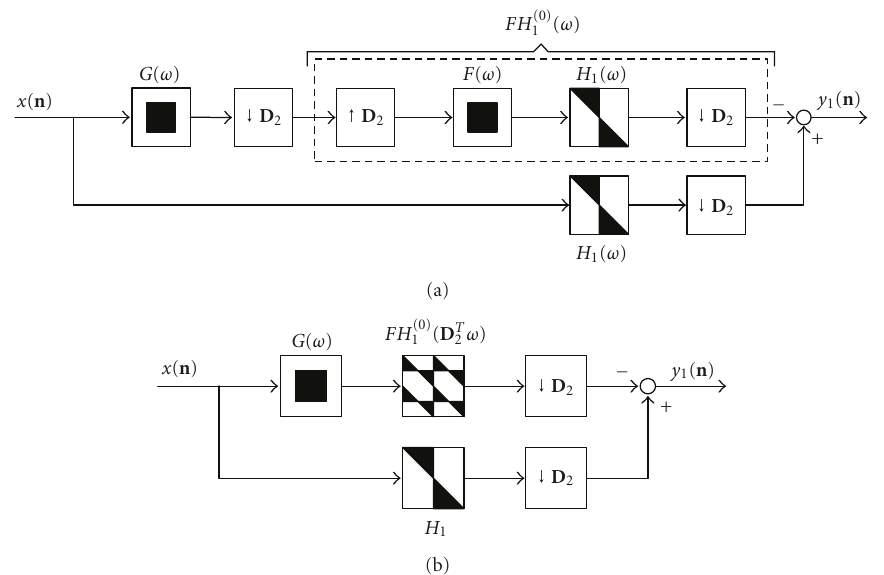
Figure 13: The equivalent structure to the directional filter (cid:16) H 1 ( ω 1 , ω 2 ) in the four-band PDFB in Figure 11.